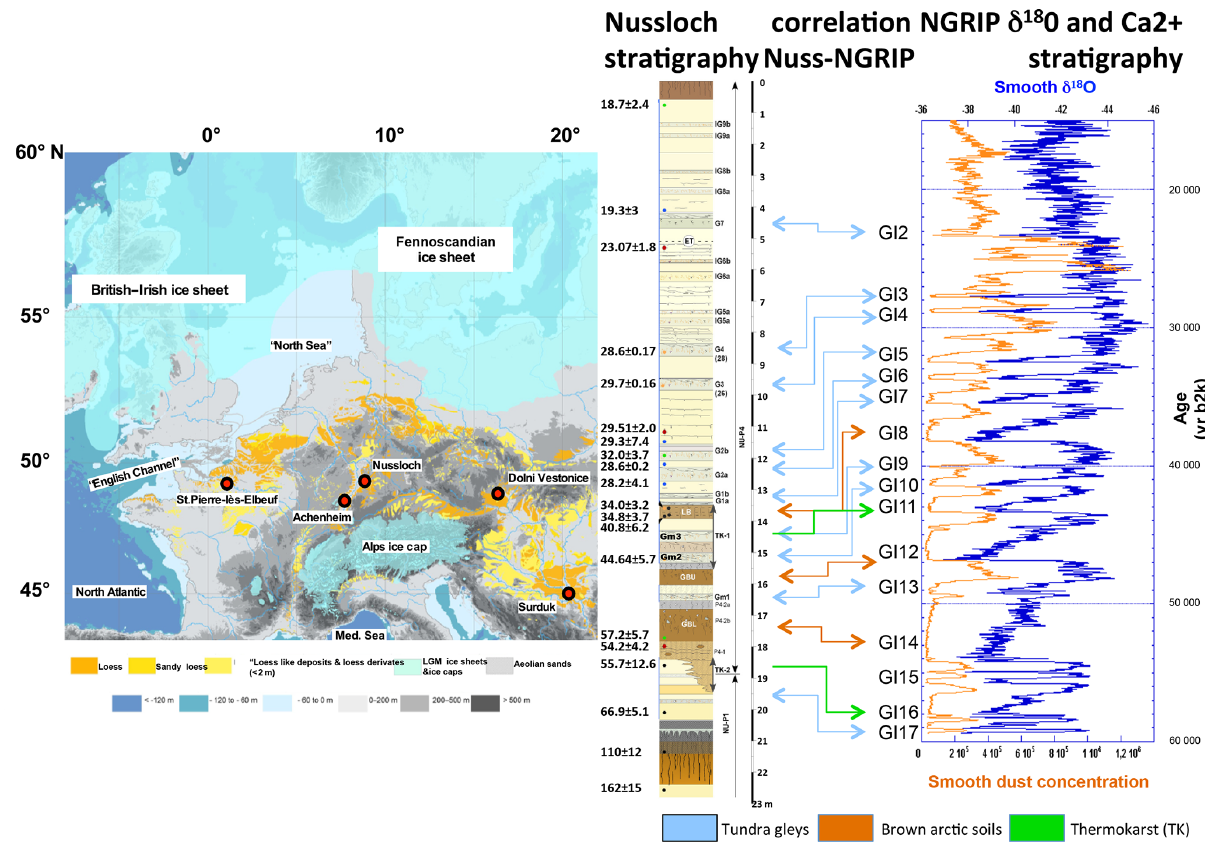
Figure 2. Stratigraphic correlations between Nussloch paleosols and NGRIP interstadials (GIs) (modified from Rousseau et al., 2017). Map as in Fig. 1. δ 18 O (‰, in blue) and the dust concentration (part/µL, in brown) records in the NGRIP ice core over the interval between 60ka and 15kab2k. Nussloch stratigraphic column from Antoine et al. (2016)